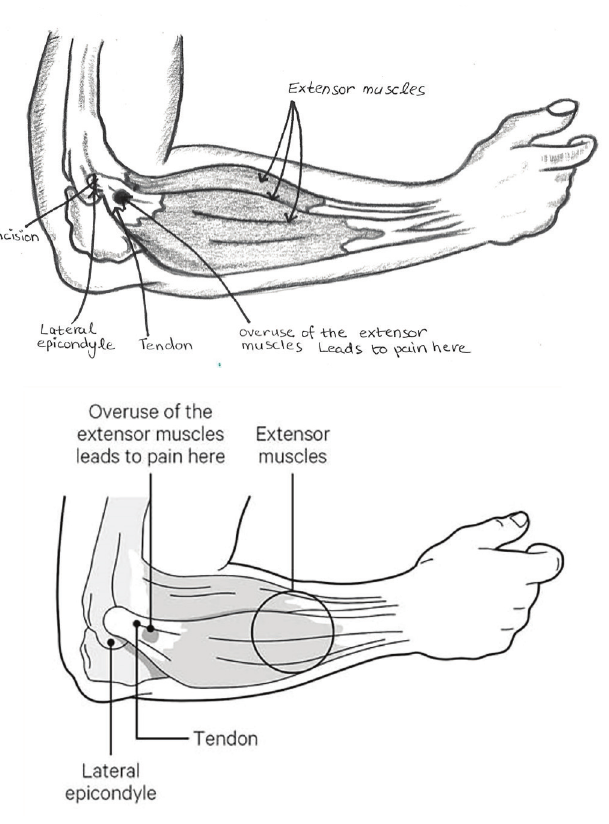
Figure 1 - Incision site for percutaneous common extensor